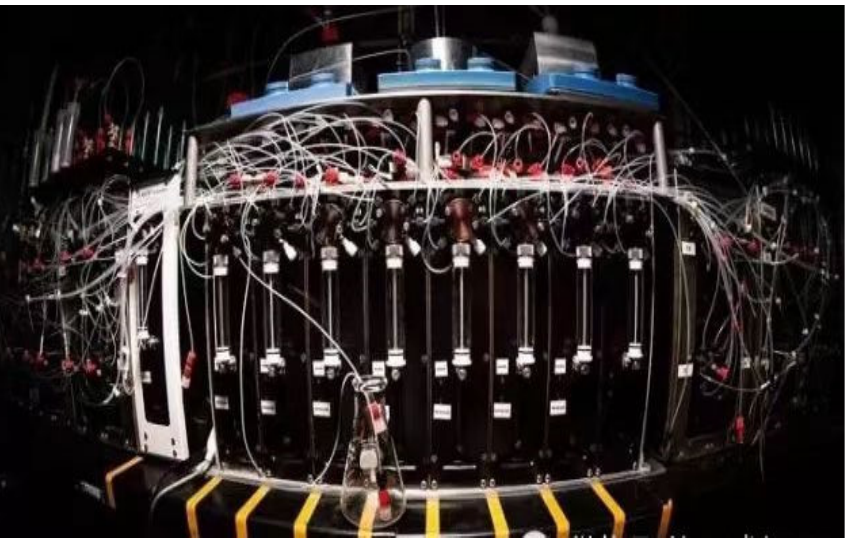
Figure 4. Model diagram of “super machine”. Adapted with permission from ref. [52]. Copyright 2015 The American Association for the Advancement of Science.